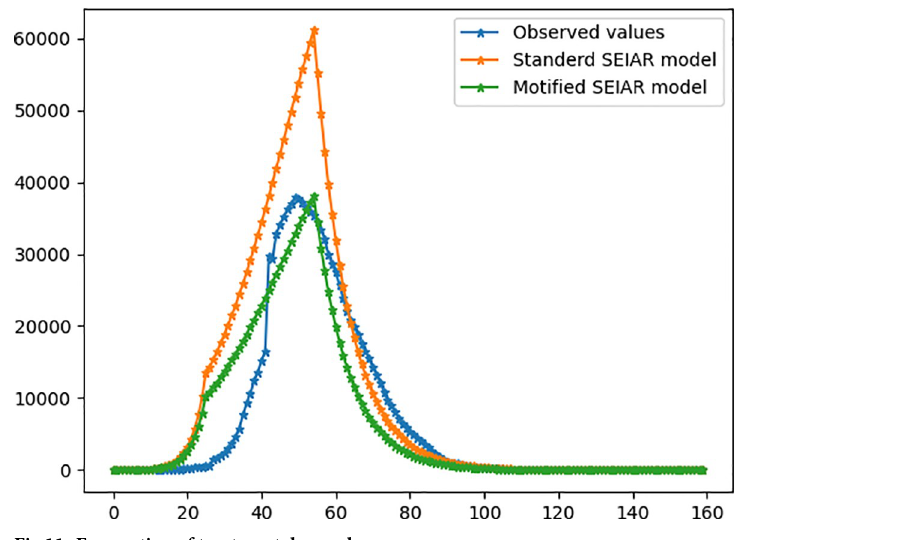
Fig 11. Forecasting of treatment